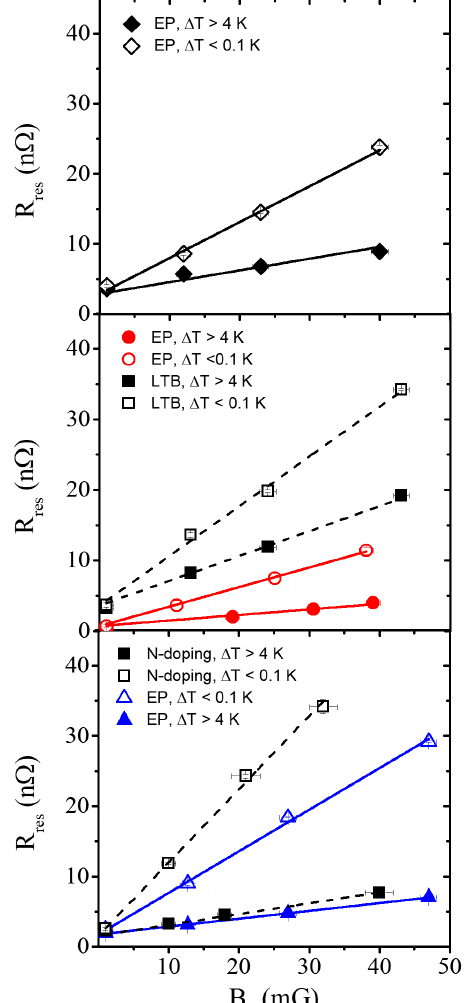
FIG. 8. Residual resistance as a function of applied dc magnetic field, B , measured for different cooldown conditions and surface n treatments for cavities TC1N1 (top), KEK-R5 (middle), and G2 (bottom). The solid lines are linear least-squares fits to the data.